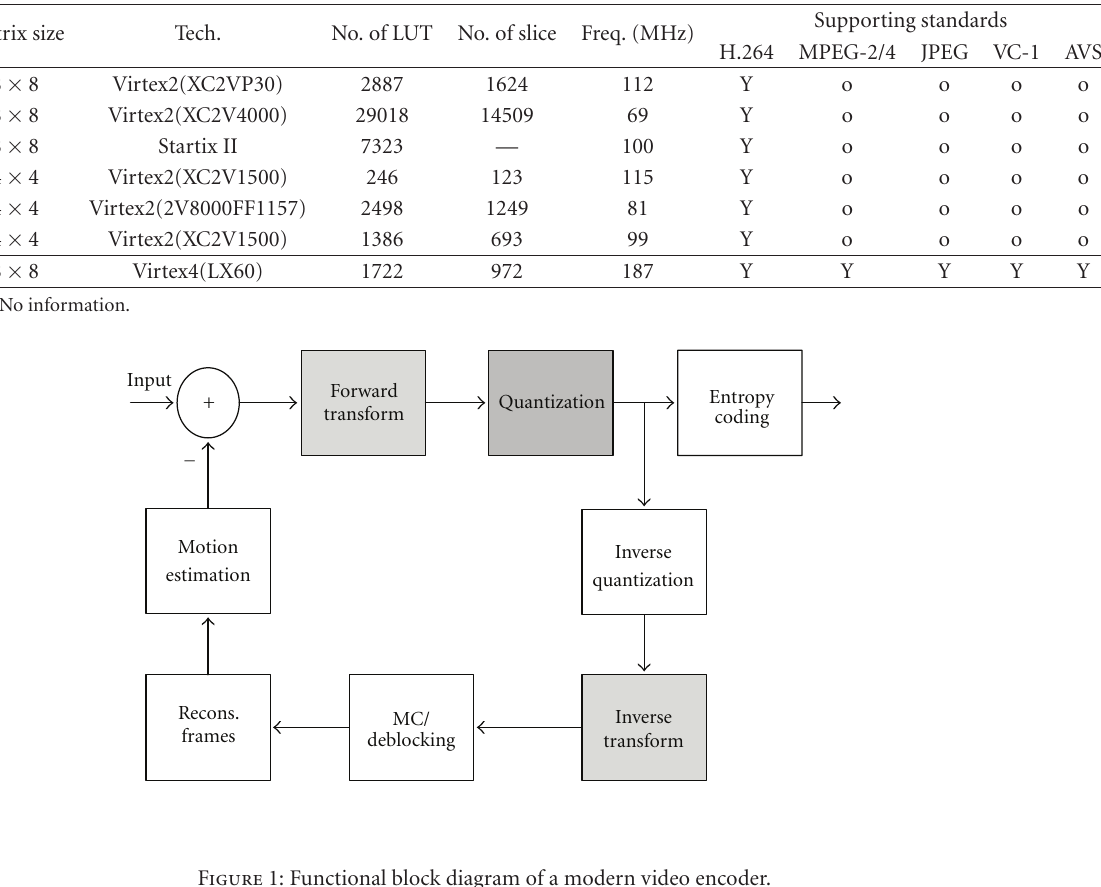
Figure 1: Functional block diagram of a modern video encoder.